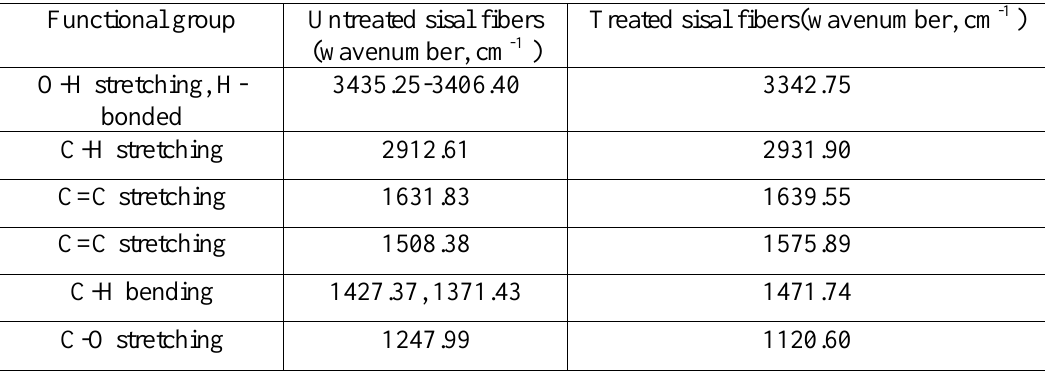
Table 2: Characterization spectral analysis of sisal fibers